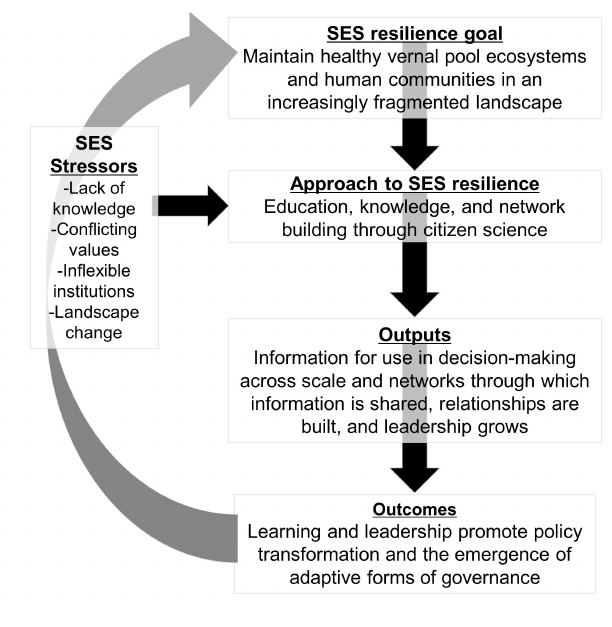
Fig. 1 . The identified resilience goal requires the development of adaptive capacity. Citizen science is an approach to social- ecological systems (SES) resilience that can promote the development of new knowledge and the formation of networks that together produce outputs and outcomes that transform key